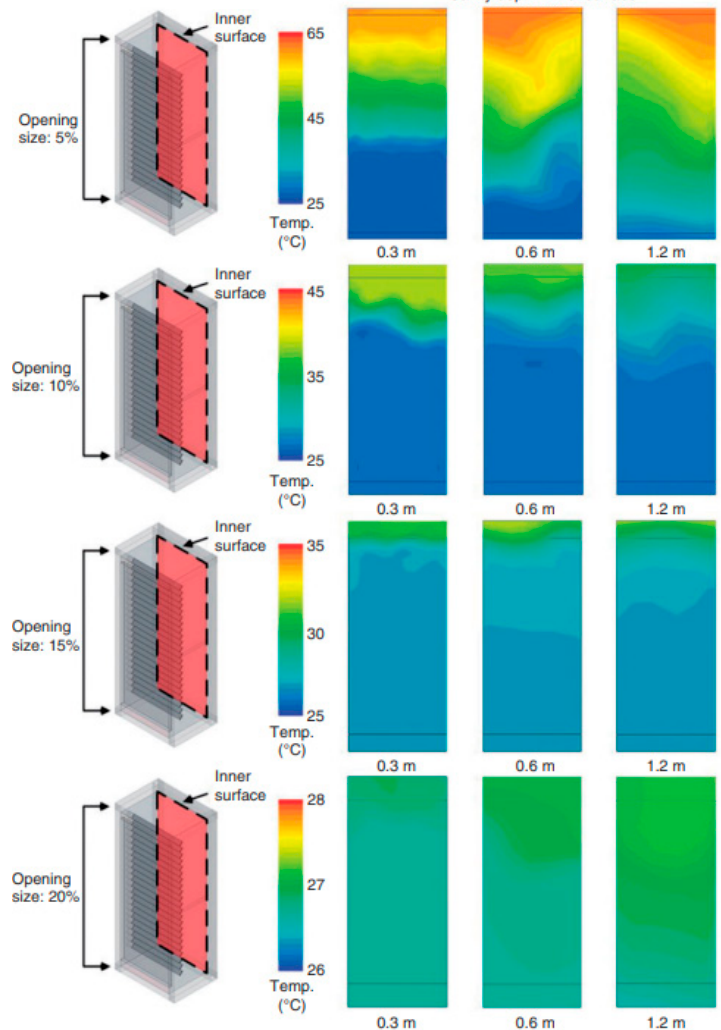
Figure 12. CFD modeling as studied (reprinted from [119]): vertical temperature distribution on the inner façade.